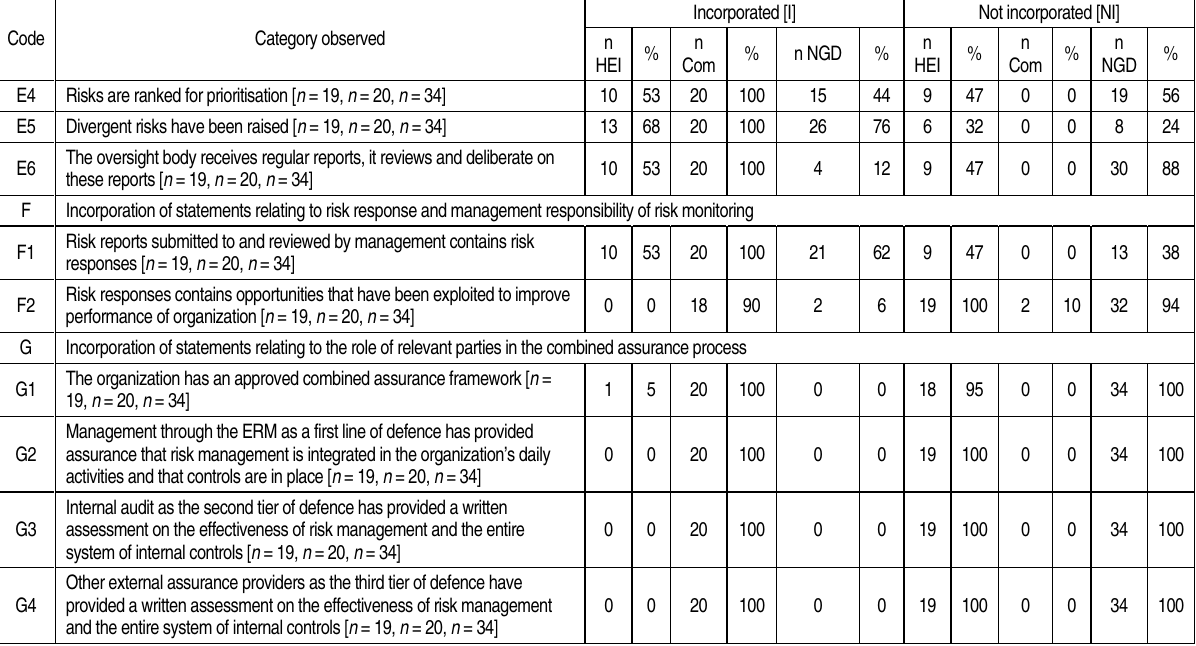
Table 2 (cont.). Incorporation of statement relating to risk approach, risk response and management responsibility, risk monitoring and the combined assurance Code Category